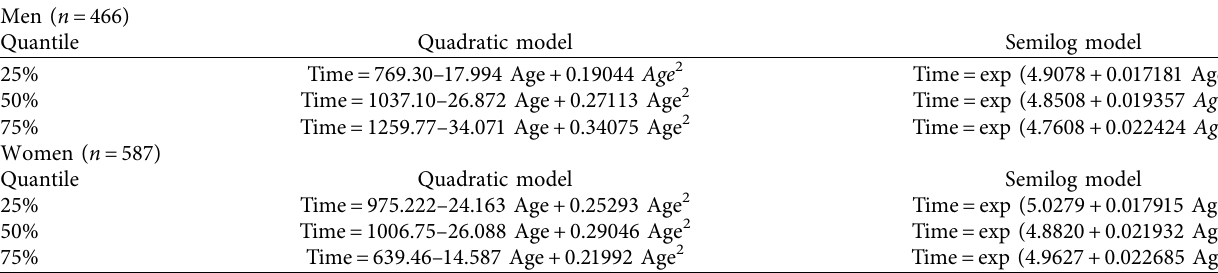
Table 5: Quantile regression